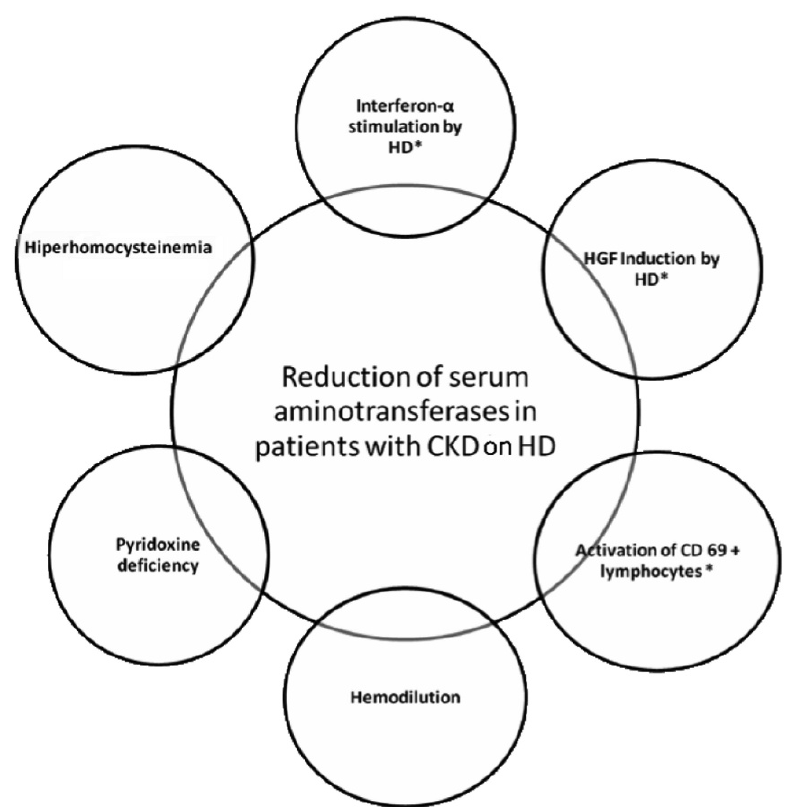
Figure 2 - Factors involved in aminotransferase reduction in patients with chronic kidney disease on hemodialysis, 2013. *Patients infected with viral hepatitis. HGF: hepatocyte growth factor; CKD: chronic kidney disease;